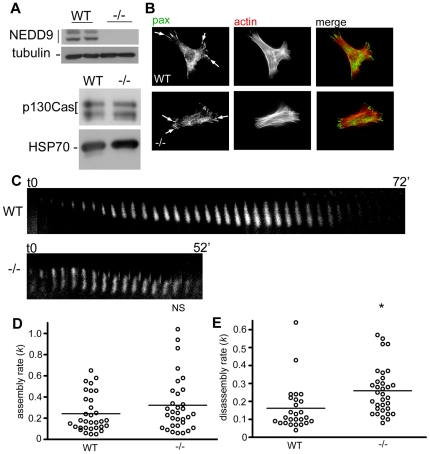
Focal adhesion turnover is more rapid in the absence of NEDD9 expression.A. Western blot analysis of extracts of wild-type (WT) and NEDD9 knockout (−/−) MEFs. Blots were probed with antibodies to NEDD9 which detects the 105 kD and 115 kD phospho-forms of NEDD9 and p130Cas antibodies as indicated. Blots were then probed with anti-tubulin or anti-HSP70 antibodies to confirm equal loading. B. WT and NEDD9 −/− MEFs immunostained with antibodies to paxillin (pax) to detect focal adhesions (white arrows) and TRITC-phalloidin to detect actin stress fibres. C. Examples of YFP-paxillin positive focal adhesions in transfected WT (72 minute lifetime) and NEDD9−/− MEFs (52 minute lifetime) are shown. D. Focal adhesion assembly rate constants (k) for cells transfected with YFP-paxillin (n = 32 focal adhesions per cell line). Horizontal bars show the average value per cell line. E. As for D, except data showing the disassembly rate constants (k). (WT n = 26, −/− n = 33). *p<0.01, N.S. = not significant.